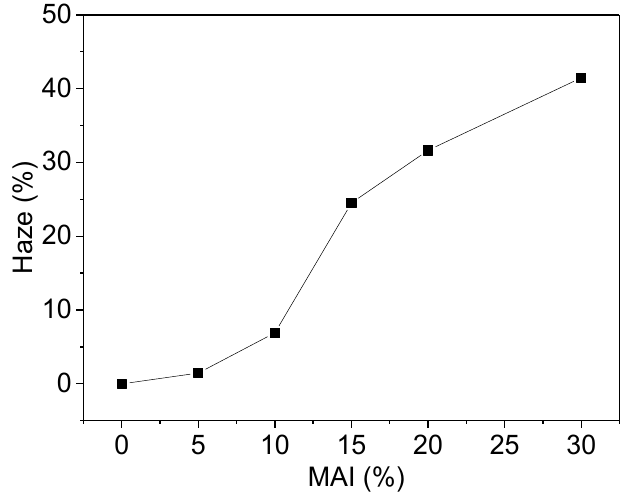
Figure 7. Haze of SPSA films with MAI content.